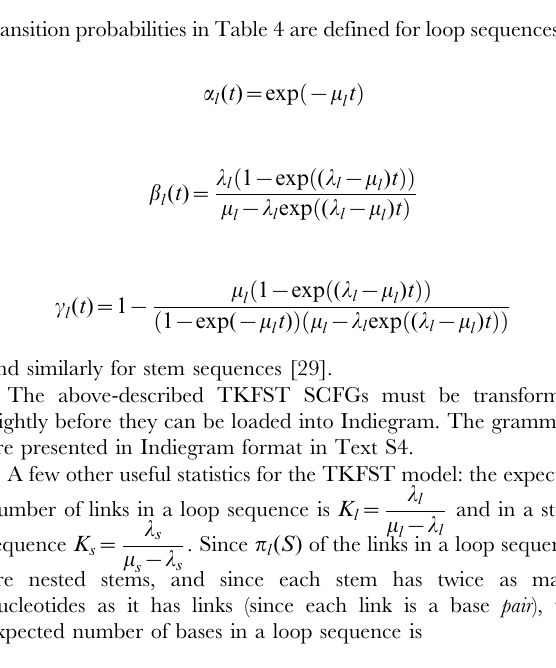
Figure 8. The TKF Structure Tree model represents the evolution of RNA structure as nested stem and loop sequences. The model consists of recursively nested loop sequences (gray, horizontal) and stem sequences (black, vertical). The loops are sequences of unpaired bases and the stems are sequences of covarying base-pairs. Both loop and stem sequences evolve according to the Thorne-Kishino-Felsenstein (TKF) model [44] of molecular evolution. Figure is extended from a similar version in [29].